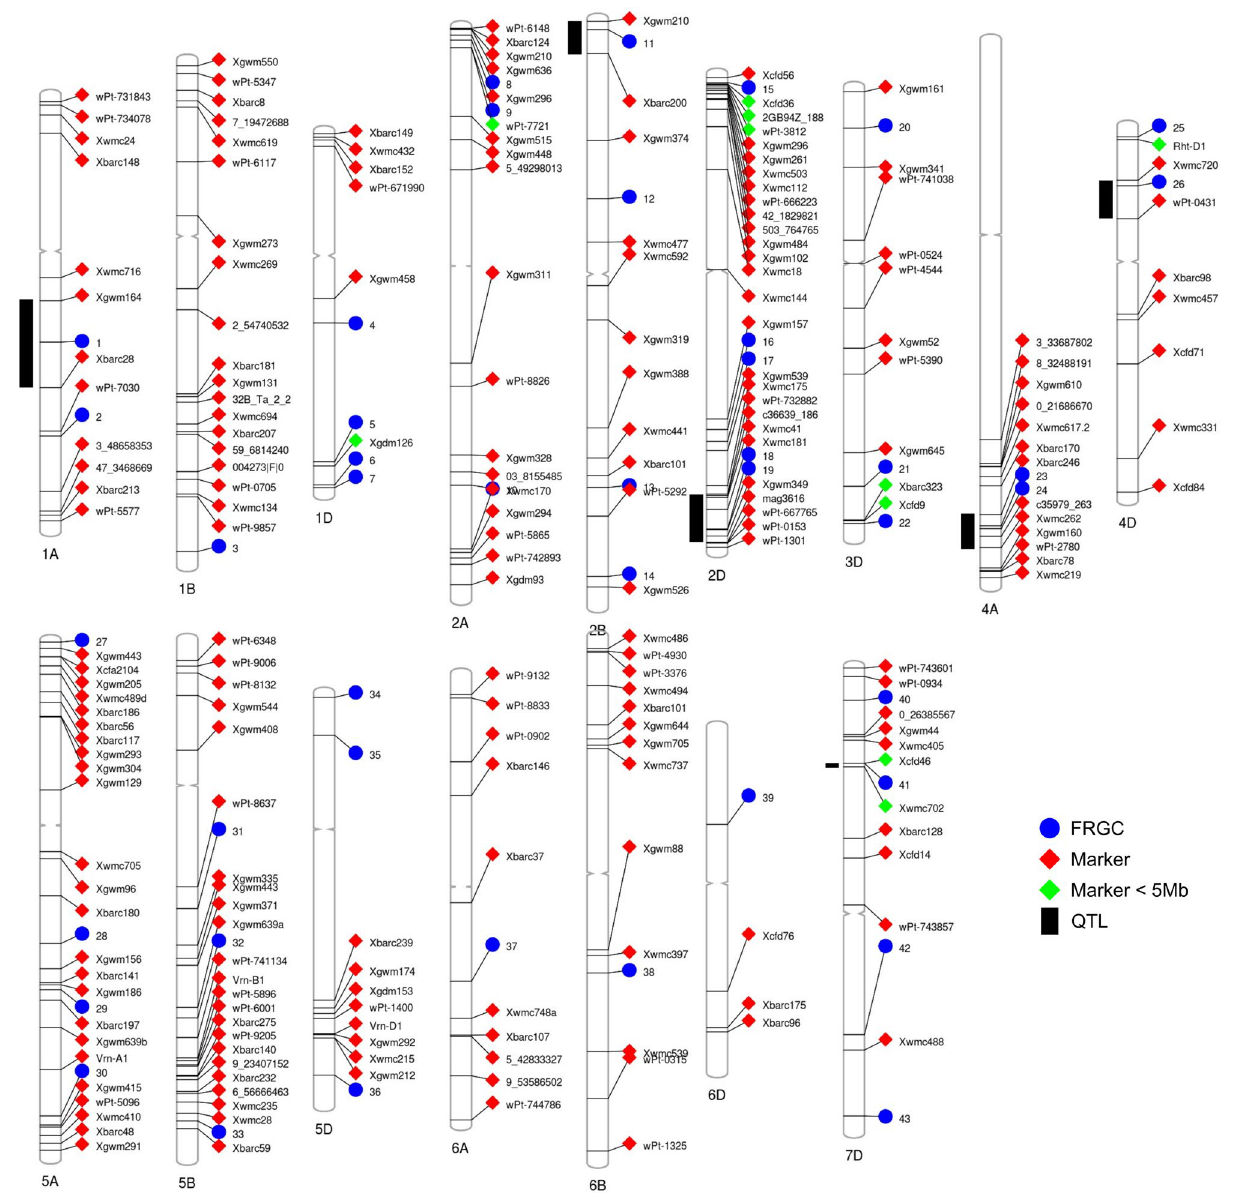
Figure 5. Chromosomal distribution of FRGCs, FHB QTL and associated markers. Fusarium -responsive gene clusters and 216 FHB QTL molecular markers were mapped based on their genome positions on the 21 wheat chromosomes. Six QTL regions (Chromosome 1A, 2B, 2D, 4A, 4D and 7D), in which the distance between flanking markers is less than 150 Mb and encompass FRGCs, are indicated with a black vertical bar. FRGCs are represented with a blue circle, and markers with a square, either red if the marker is physically > 5 Mb from a cluster, or green if the marker is physically < 5 Mb from a cluster. Centromeric region are represented as the restricted central region of the